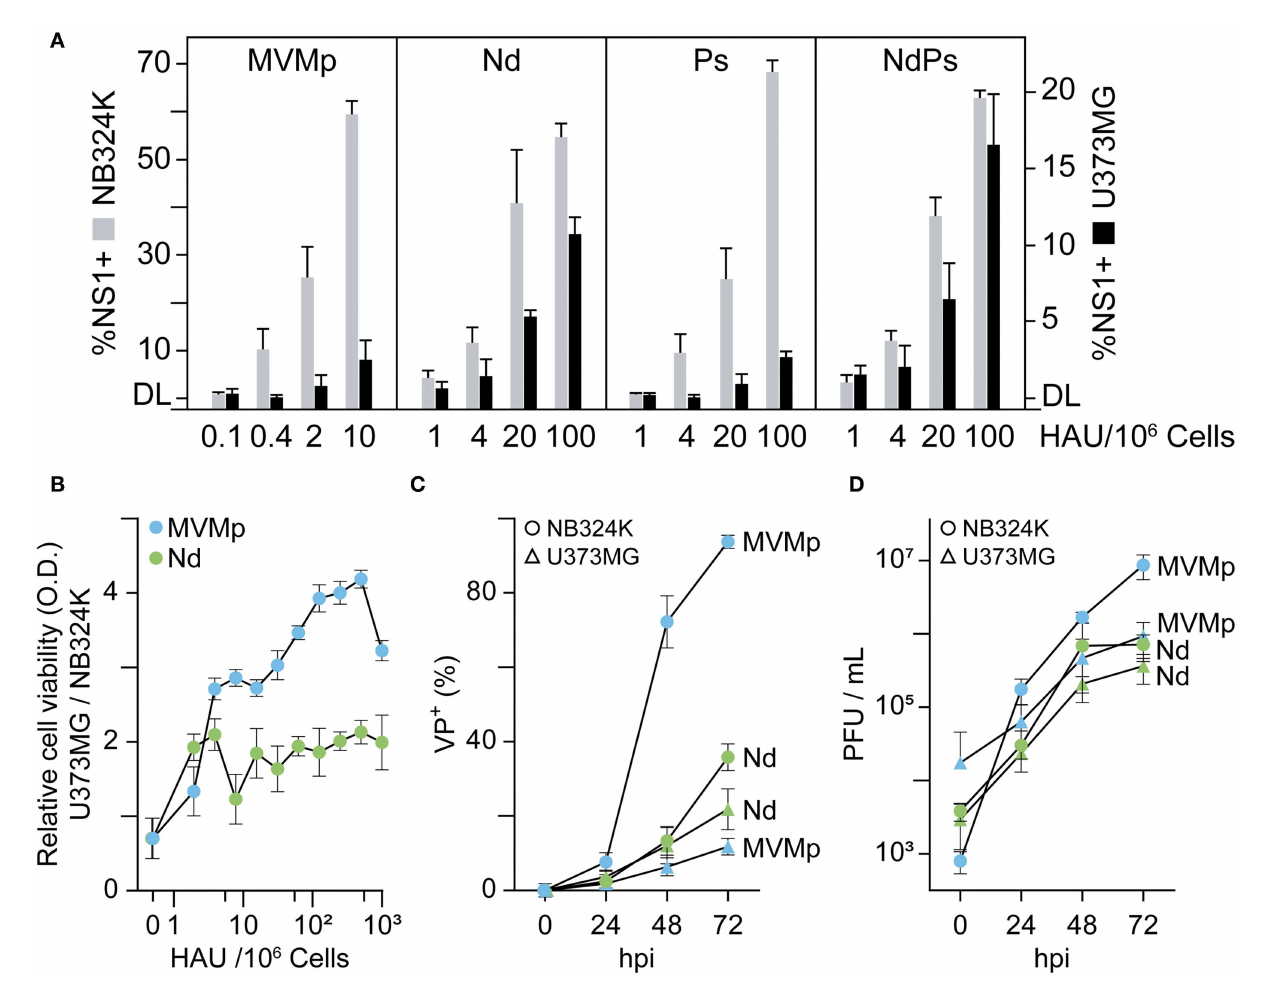
FIGURE3 Effect of VEbp insertions on MVMp tropism toward human glioblastoma cells. (A) Relative infectivity of MVMp and chimeric Nd, Ps, and NdPs virions in NB324K- and U373MG-transformed human cells. Monolayers of 10 6 cells were inoculated with the indicated graded amounts of purified virions quantitated as hemagglutination units (HAUs), and the infection was quantitatively scored at 24 hpi by confocal IF staining of NS1 expressing cells. Values correspond to the mean with standard errors of two independent experiments and were obtained by visually counting cells from at least three fields per experiment (n ≥ 10 3 ). (B) Relative cytotoxic capacity of the MVMp and Nd viruses in U373MG and NB324K cells. Cells seeded onto M96 well plates were inoculated with the indicated serial amounts of purified virions and viable cells determined at 3 dpi by MTT staining. OD, optical density. (C) Comparative analysis of the progression of MVMp and Nd infection in U373MG and NB324K cultures inoculated at low multiplicity monitored by IF staining of capsid protein (VP) expressing cells with the anti-VPs antibody. (D) Production of total infectious viral particles along the time in cultures infected at low MOI. Values in (B–D) are the means with standard errors from three determinations. DL, detection limit of the assay.